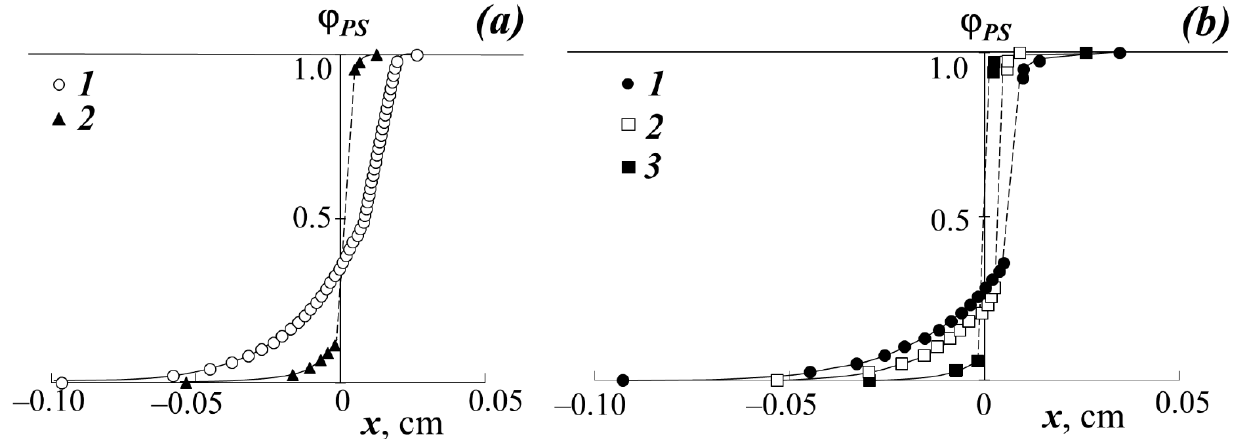
Figure 3. Concentration profiles at 433 K: ( a ) when mixing PBA with PS-1 (1) and PS-2 (2); ( b ) when mixing PS-1 with PEHA (2), PEA (3), and PMA (4).